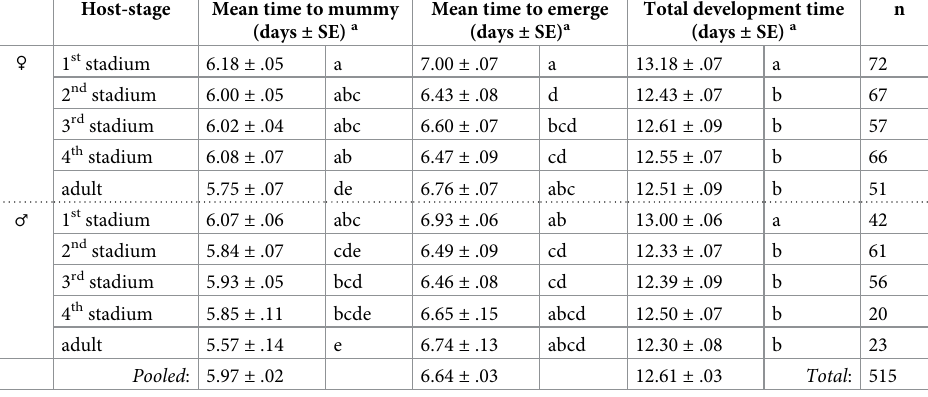
Table 1. Development time for Aphelinus certus on the various stages of soybean aphid separated by parasitoid sex with two-factor